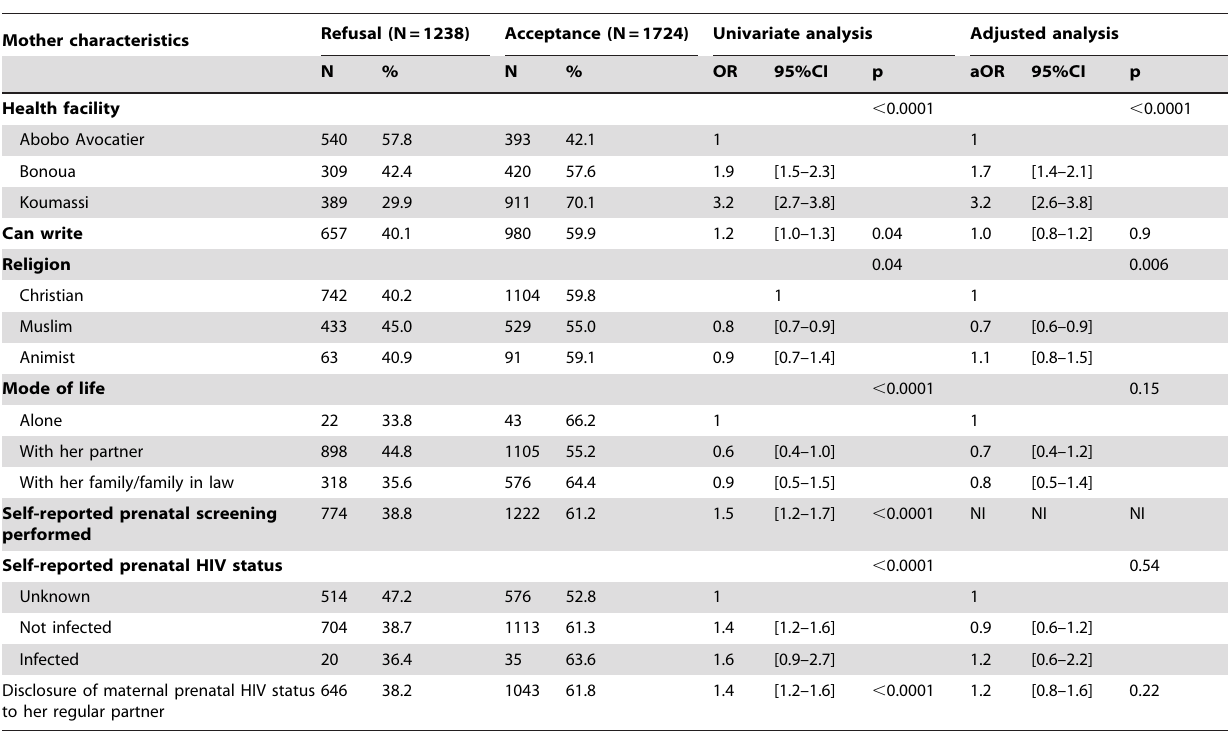
Table 2. Correlates of maternal acceptance (n= 2962) of infant HIV testing (logistic regression).